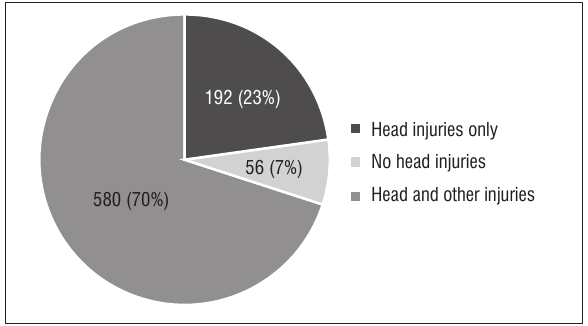
Figure 5: Proportion of head injuries in blunt force trauma homicides.